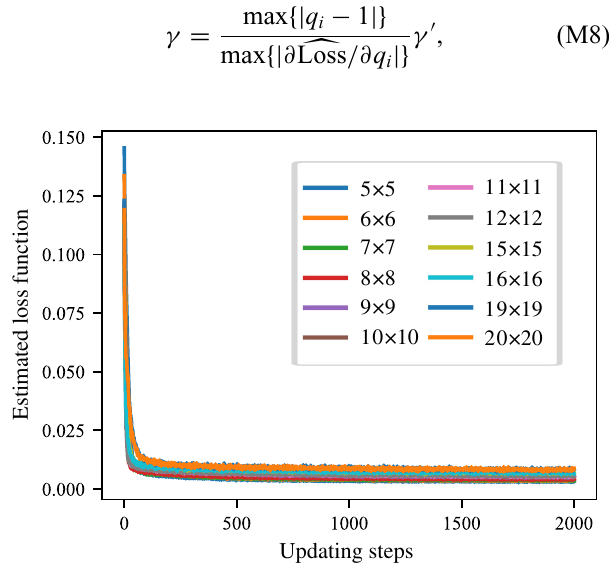
FIG. 19. Values of the loss function in the gradient descent. We use n × N to denote an n -qubit, N -layer circuit. For each